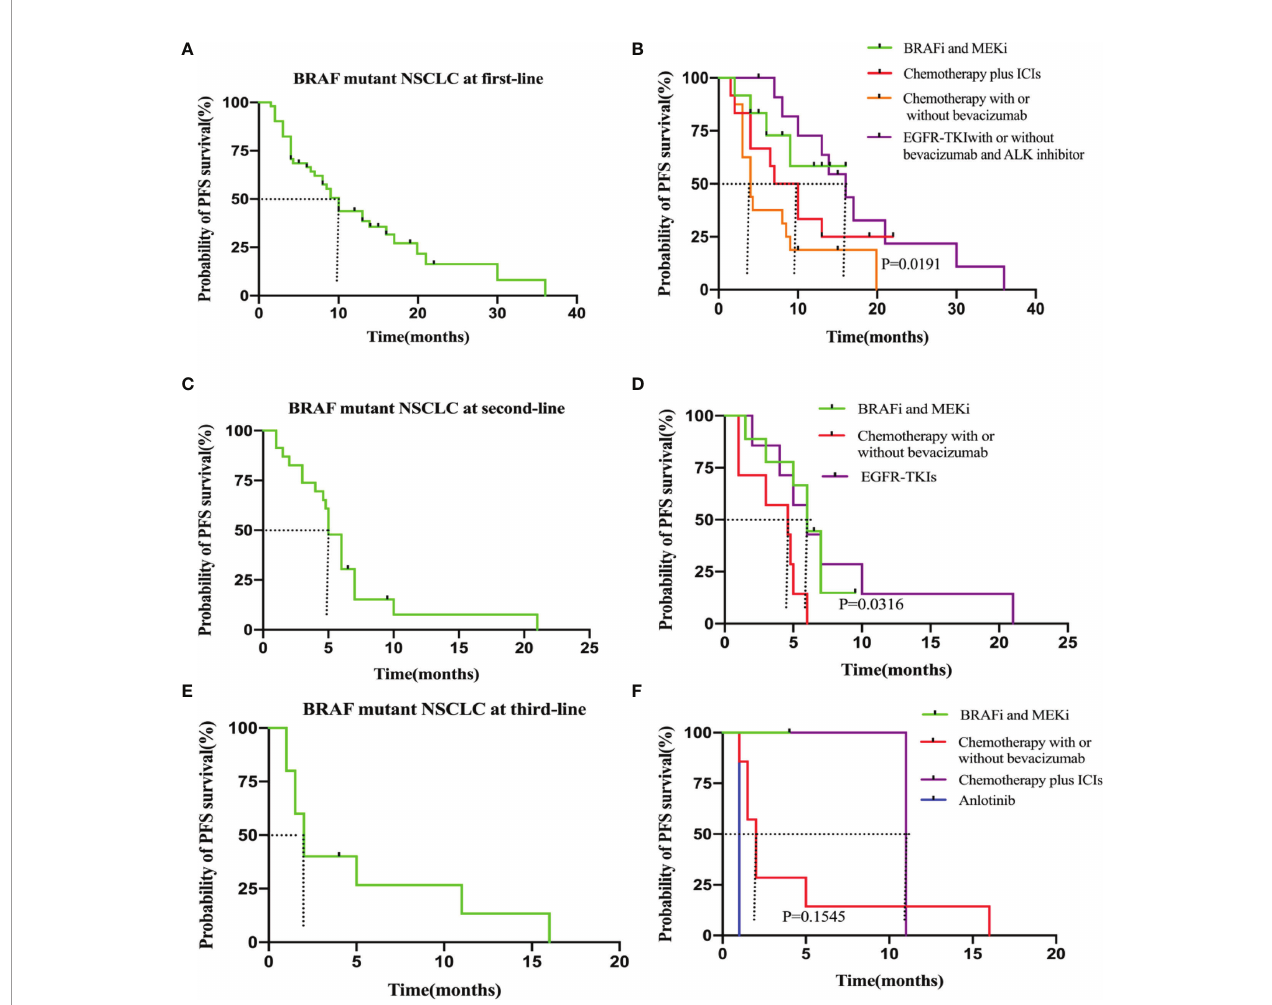
FIGURE 2 | (A) PFS in the all patients at fi rst-line. (B) PFS in the subgroup of patients who received BRAF and MEK inhibitor (n = 12), chemotherapy plus ICIs (n = 12), chemotherapy with or without bevacizumab(n=16) and EGFR-TKIs with or without bevacizumab/ALK inhibitor (n = 11). (C) PFS in the all patients at second-line. (D) PFS in the subgroup of patients who received BRAF and MEK inhitor (n = 9), chemotherapy with or without bevacizumab (n=7) and EGFR-TKIs (n=7). (E) PFS in the all patients at third-line. (F) PFS in the subgroup of patients who received chemotherapy with or without bevacizumab (n = 7), BRAF and MEK inhitor (n = 1), chemotherapy plus ICIs (n=2) and anlotinib